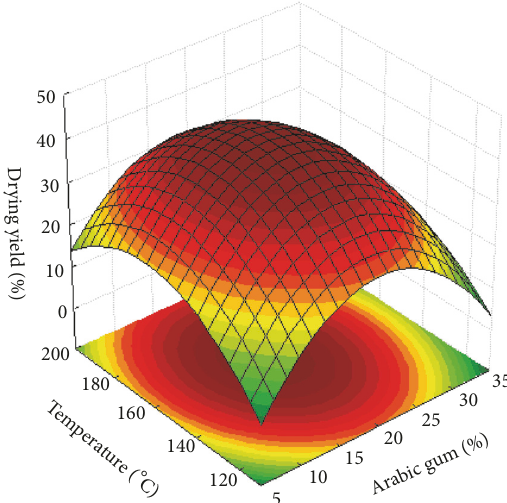
Figure 5: Response surface fitted to drying yield as a function of arabic gum concentration and